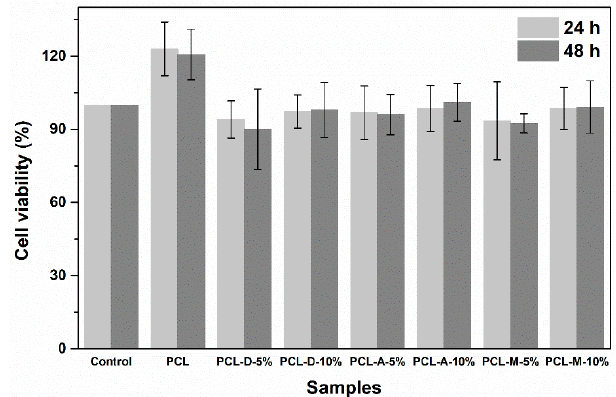
Figure 6. Cell viability for fibroblasts in contact with the electrospun samples for 24 and 48